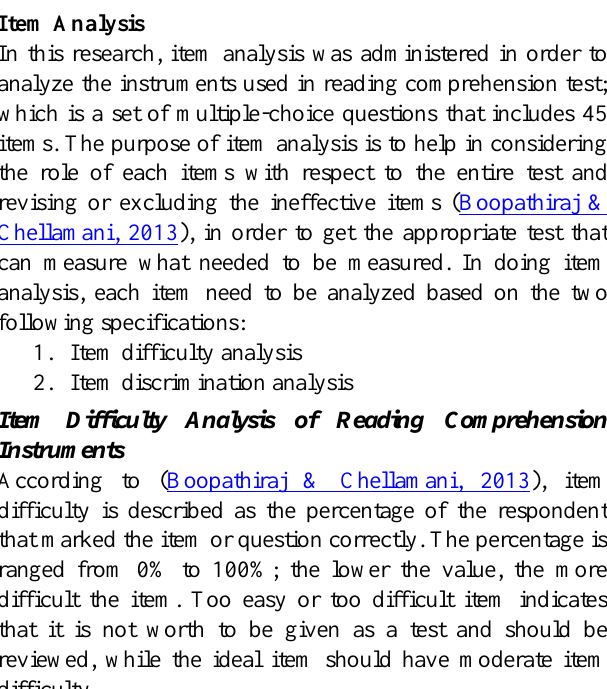
TABLE 3 | Item Difficulty Analysis of Reading